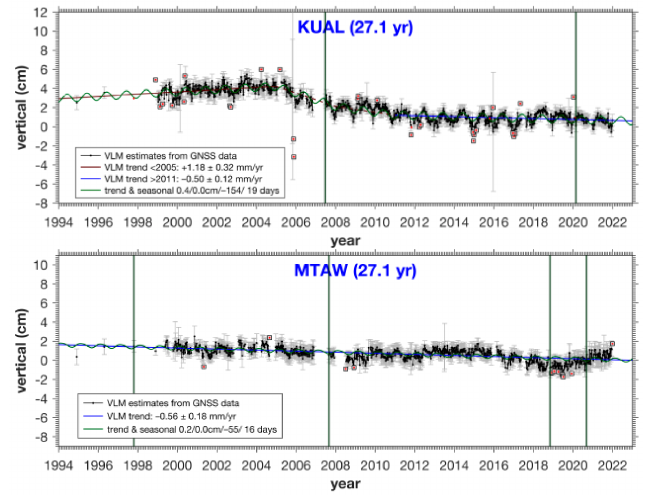
Figure 10. Vertical land motion estimates for KUAL in Peninsular Malaysia (split trend lines) and MTAW in Sabah, East Malaysia (single trend line) (1994–2021). For each station, the vertical position time series is given along with the total observation period. The reference vertical position is given on 1 January 2022 (0 cm). The green vertical lines are the epochs at which a vertical position jump (due to antenna change or MASS to MyRTKNet transition) was estimated. The linear trend lines are given in brown (<2005) and blue (>2011) with the modeled seasonal (annual) signal (green) superimposed on it. Weekly averaged position outliers are marked in red. The vertical land motion estimate is given at a 95% (1.96 sigma) confidence level. We chose to model the exponentially decaying signal after the Sumatra–Andaman Earthquake by 3 linear segments and only consider the part after 2011 to connect closest to the present-day